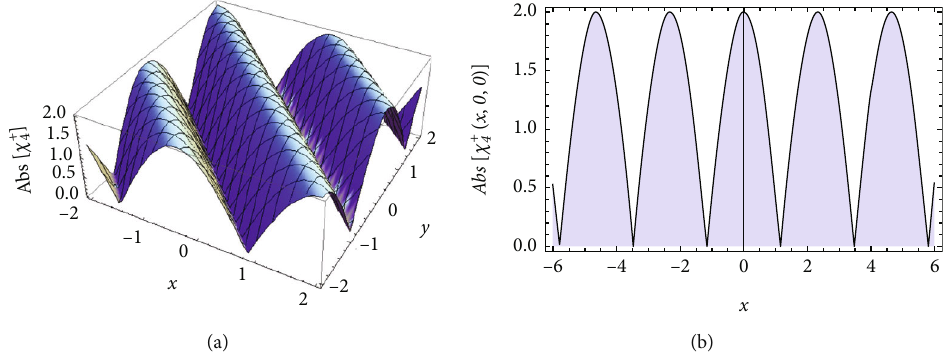
x , y , t Þj with the parameters Θ = 2 , λ = 1 , v = 1 , v 4 ð